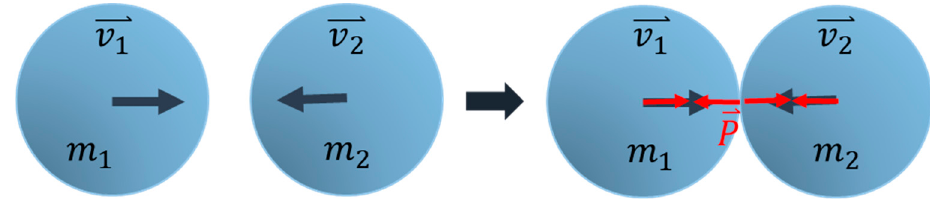
Figure 1. Schematic illustration of the elastic collision of two spheres.